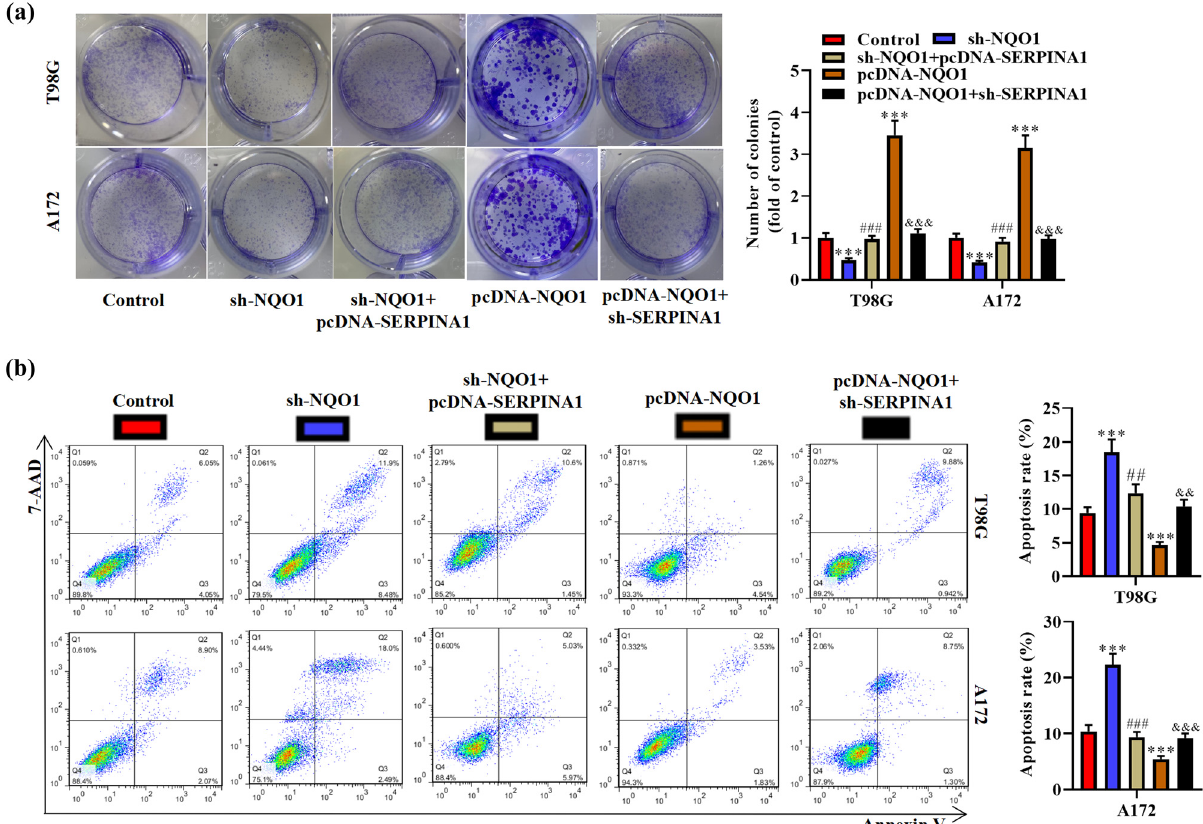
Figure 4: NQO1 boosts the proliferation of glioma cells by reducing apoptosis. ( a ) Colony formation assay and quantitative analysis of T98G and A172 cells transfected with di ff erent plasmids ( control, sh - NQO1, sh - NQO1 + pcDNA - SERPINA1, pcDNA - NQO1, pcDNA - NQO1 + sh - SERPINA1 ) . One - way ANOVA was conducted. ( b ) Annexin V/7AAD double staining assay was used to show cell apoptosis rate in T98G and A172 cells. One - way ANOVA was conducted. Data are expressed as means ± SEM ( *** p < 0.001 vs control, ## p < 0.01, ### p < 0.001 vs sh - NQO1, && p < 0.01, &&& p < 0.001 vs pcDNA - NQO1, n = 3 )